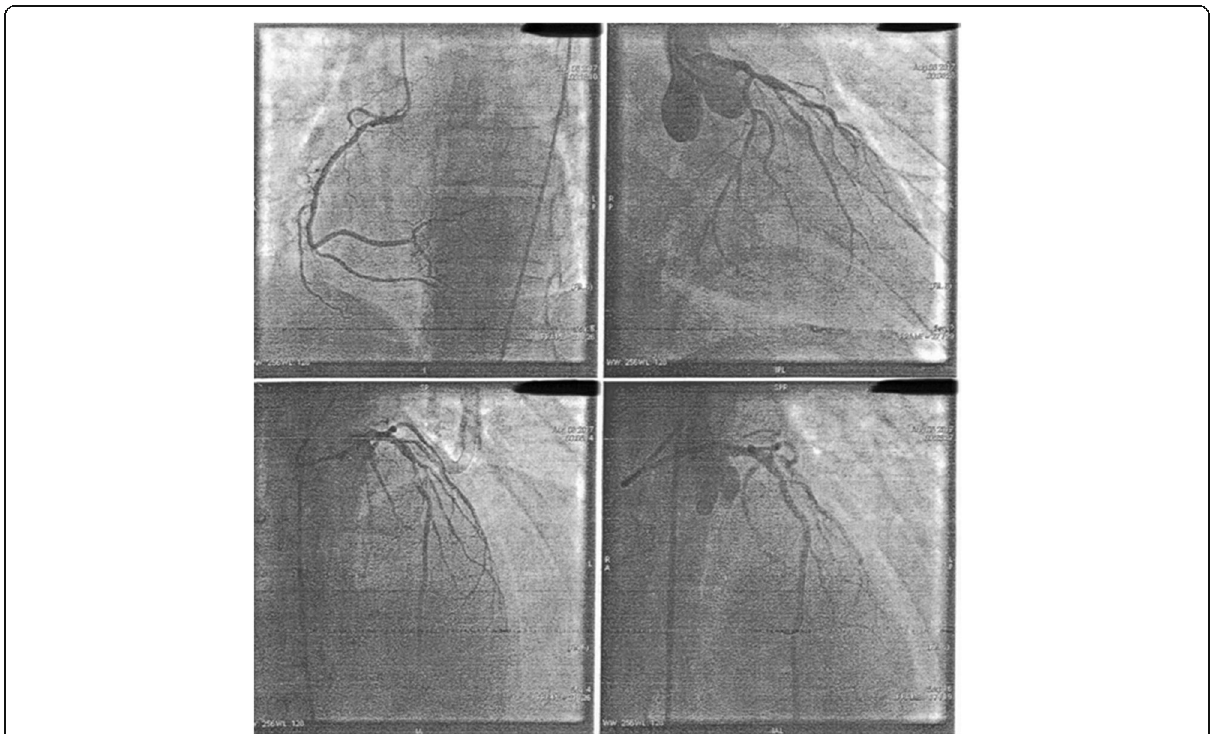
Fig. 4 Coronary angiography. Legend: Coronary angiography revealed significant stenosis of the proximal part of the left anterior descending artery (Prox LAD)